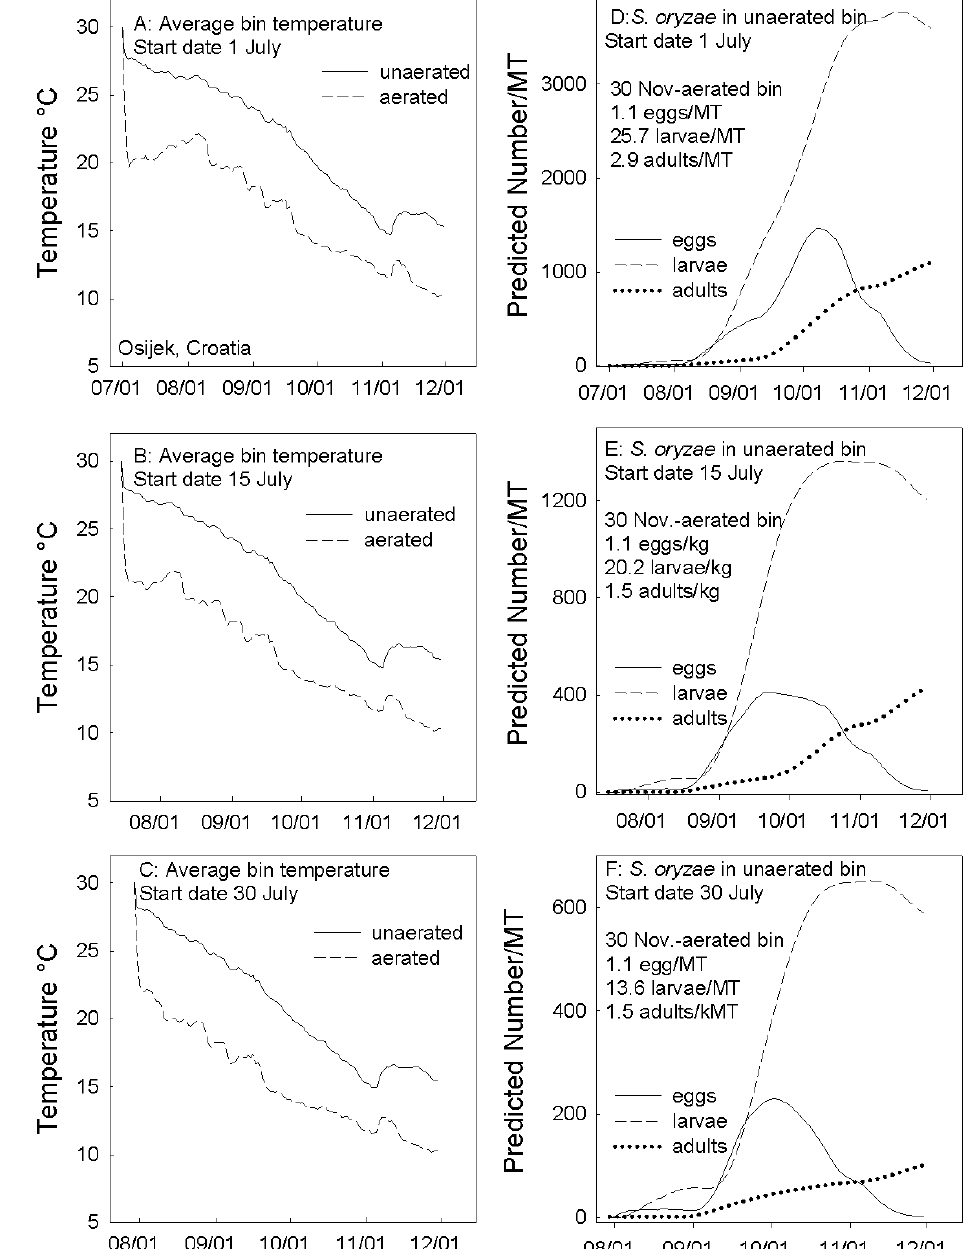
Figure 4. Predicted average bin temperatures in unaerated (solid line) and aerated wheat (dashed line) for wheat stored in Osijek, Croatia, with start dates of 1, 15, and 30 July ( A – C ). Predicted populations of eggs, larvae, and adult S. oryzae (solid line, dashed line, dotted line, respectively) in unaerated wheat with those start dates are plotted in ( D – F ). Data for predicted populations of eggs, larvae, and adults in aerated wheat are given as text inside ( D – F ).